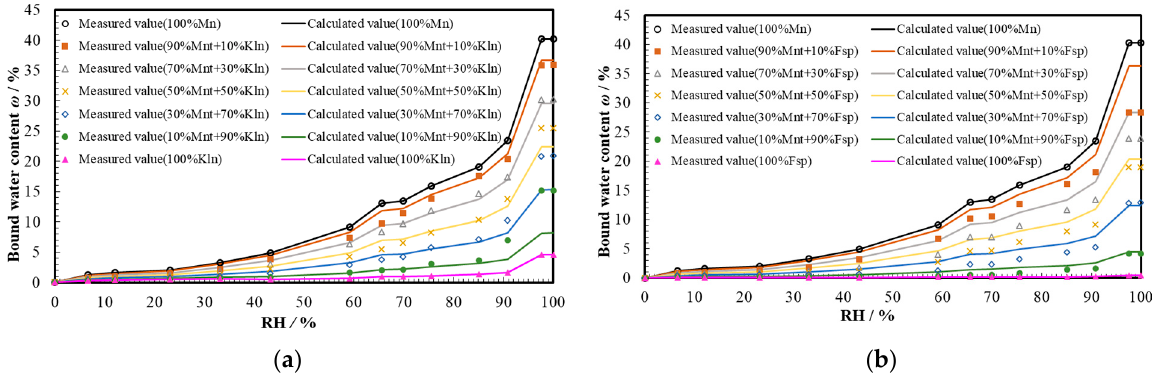
Figure 8. Superposition isotherms adsorption of mixed soils. ( a ) Type II (mixed soils with Mnt + Kln), ( b ) Type III (mixed soils with Mnt + Fsp).